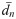
The results of the randomized sampling procedures (where g1: Coefficient of skewness. g2: Coefficient of kurtosis, dn¯: The average value of dn).